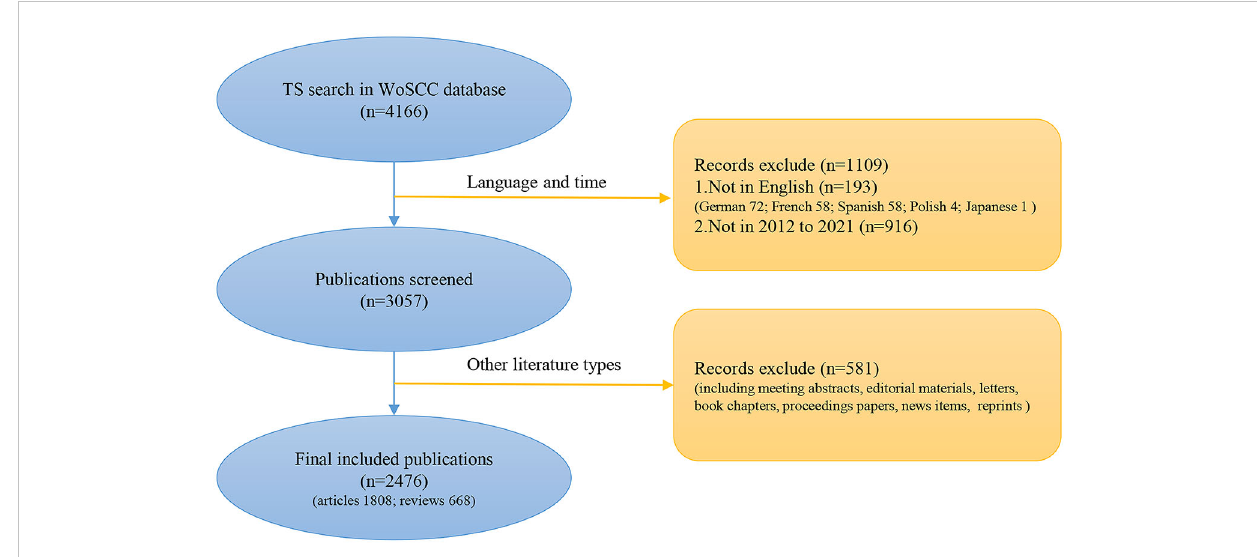
FIGURE 1 Data retrieval processing fl ow